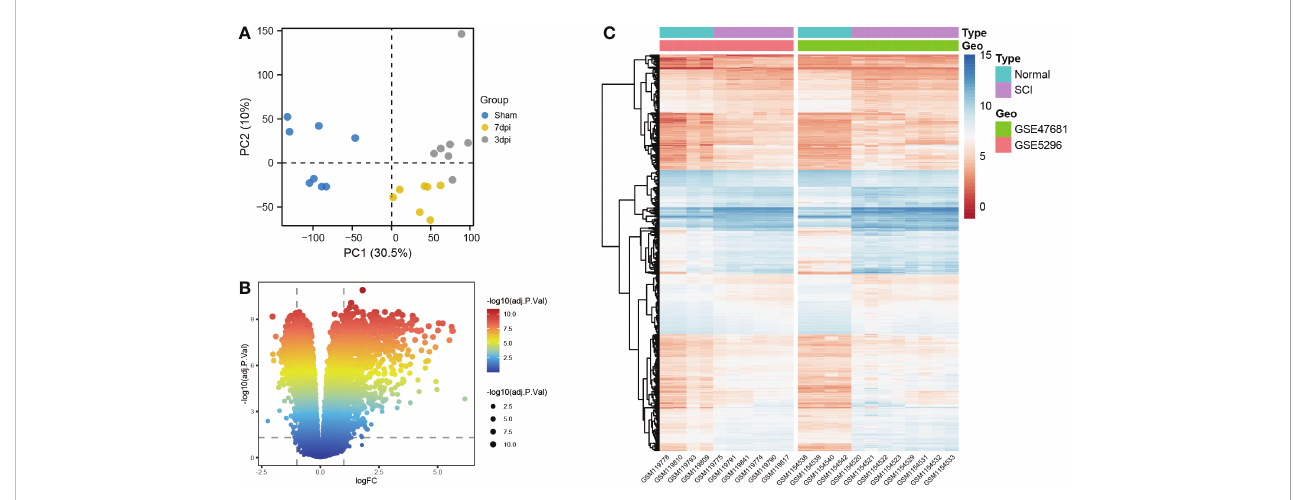
FIGURE 2 Screening for differentially expressed genes (DEGs) of bulk RNA-seq datasets. (A) Principal component analysis (PCA) analysis of GSE5296 and GSE47681. (B) Volcano plots of DEGs, screening criteria: |log 2 (fold-change) (FC)>1 and an adjusted p<0.05. (C) Heatmap of